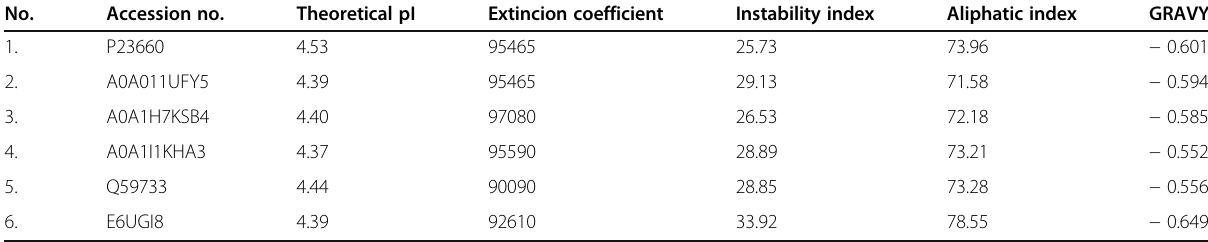
Table 3 Physicochemical properties of selected proteins, from different strains of Ruminococcus albus